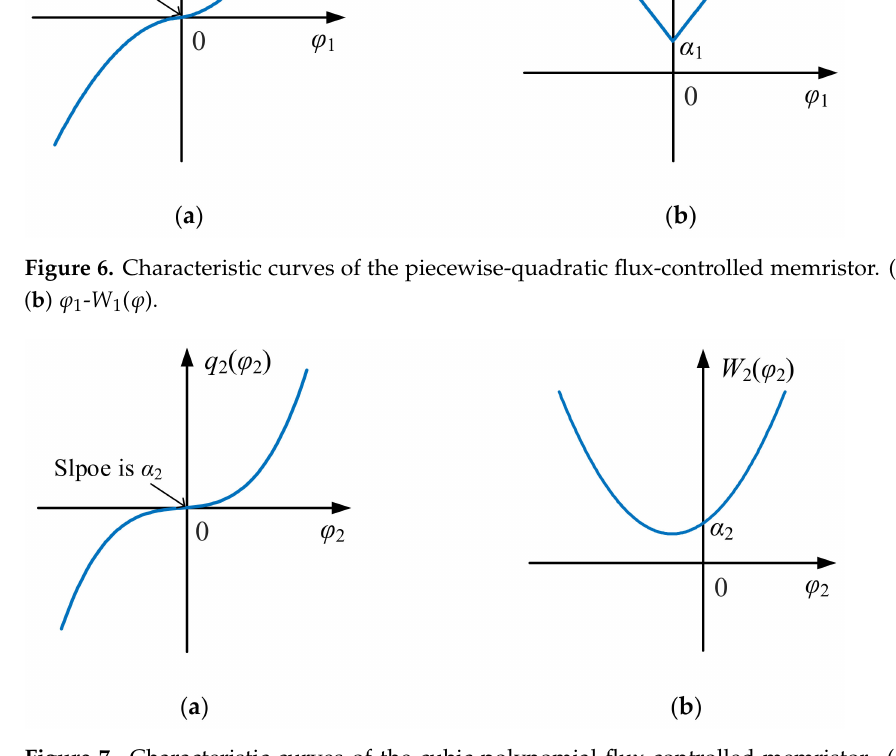
Figure 7. Characteristic curves of the cubic polynomial flux-controlled memristor. ( a ) ϕ 2 - q 2 ( ϕ ); ( b ) ϕ 2 - W 2 ( ϕ